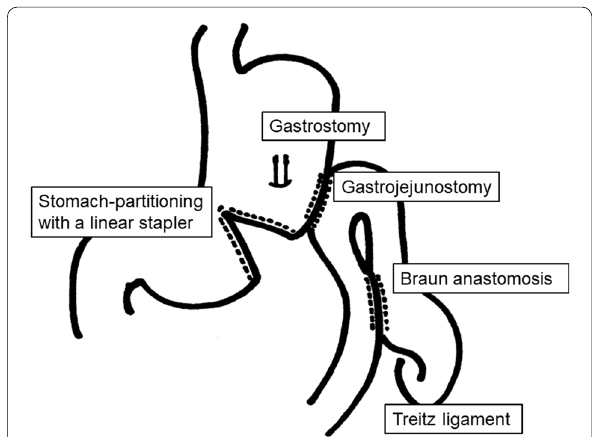
Fig. 4 Schematic figure of the operation. The greater curvature of the stomach was transected with a linear stapler to increase flow to the jejunal bypass (stomach-partitioning). The gastrostomy was placed on the oral side of the gastrojejunostomy